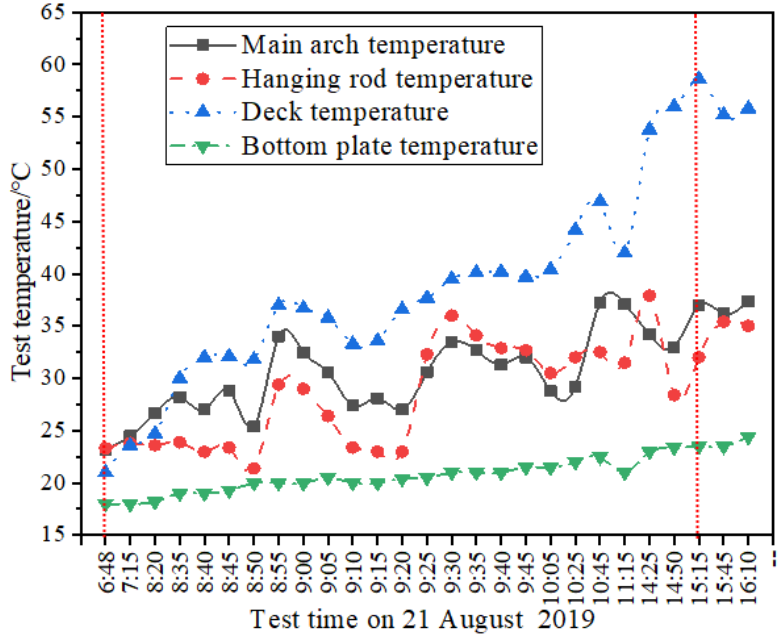
Figure 12. Monitored temperature of different parts.